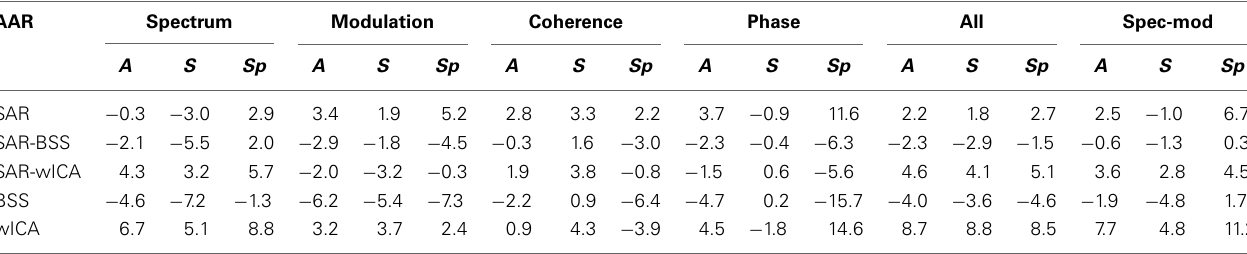
Table 3 | Relative gains obtained after AAR for the 2-class “ N vs. AD 1” task. AAR Spectrum